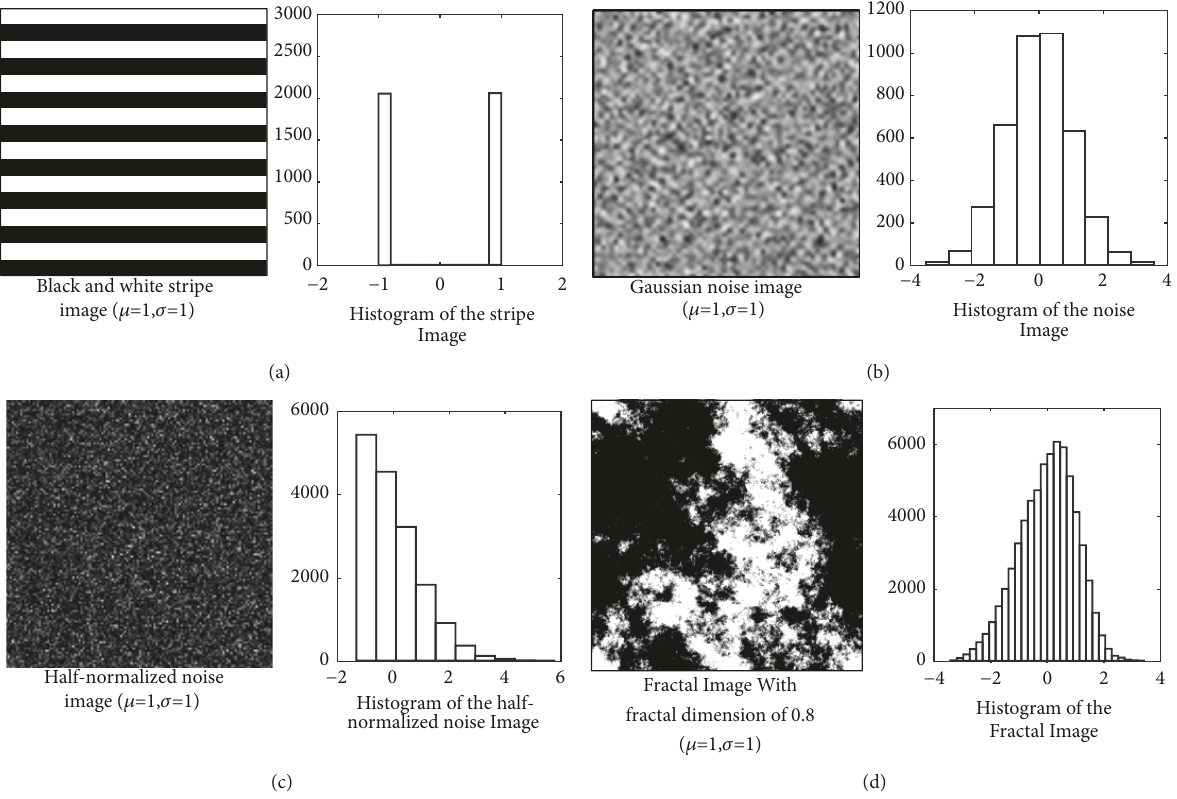
Figure 1: Four kinds of different artificial texture images sampling from different LSD model but both with zero means and unit variance. (a) An artificial black and white stripe texture image sampling from a uniform distribution model. (b) A Gaussian distributed 2D random texture image. (c) A half-normal distributed noise image. (d) A fractal texture image with the fractal dimension of